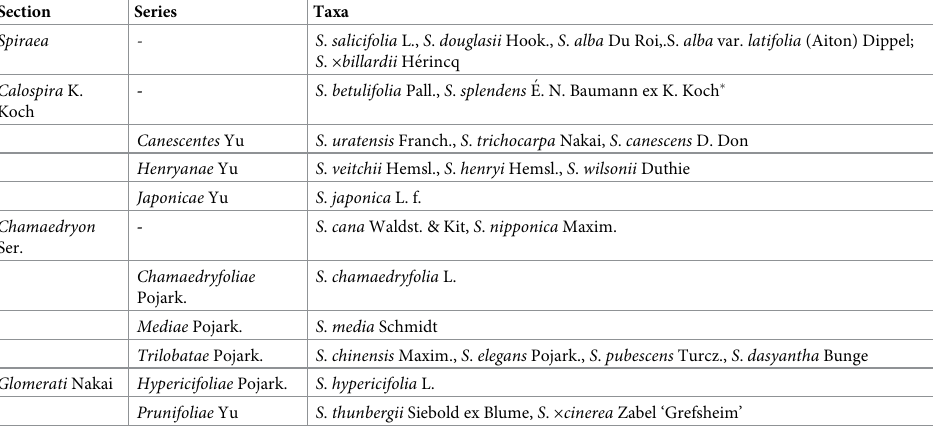
Table 2. List of taxa analyzed with their affiliation to particular sections and series.